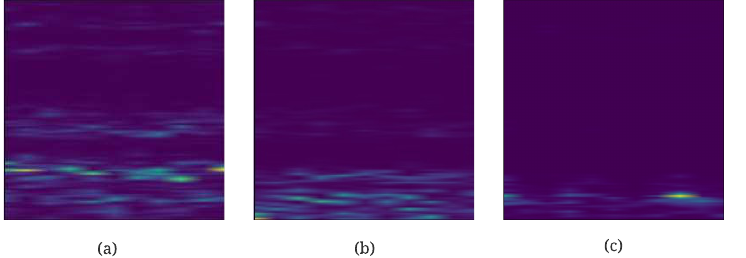
Figure 3. Spectrogram of vibration signals of bearings in different health states; ( a – c ) refer to States 0 to